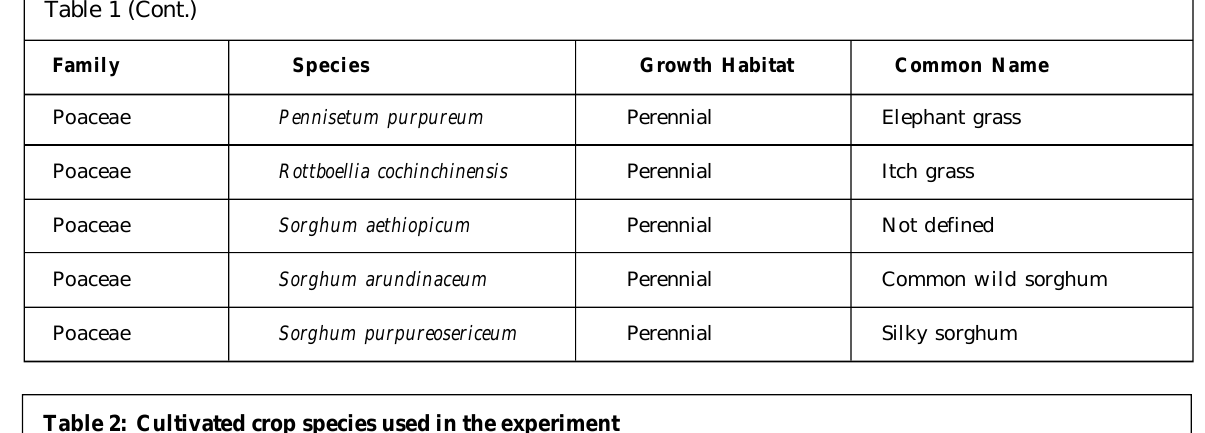
Table 2: Cultivated crop species used in the experiment Family Common Name Botanical Name Convolvulaceae